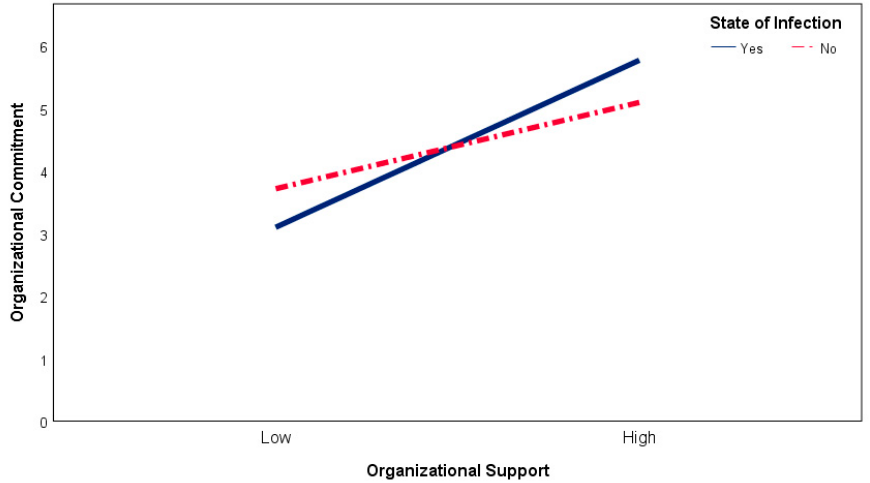
Figure 2. Moderating role of state of infection on organizational support–organizational commitment relationship.